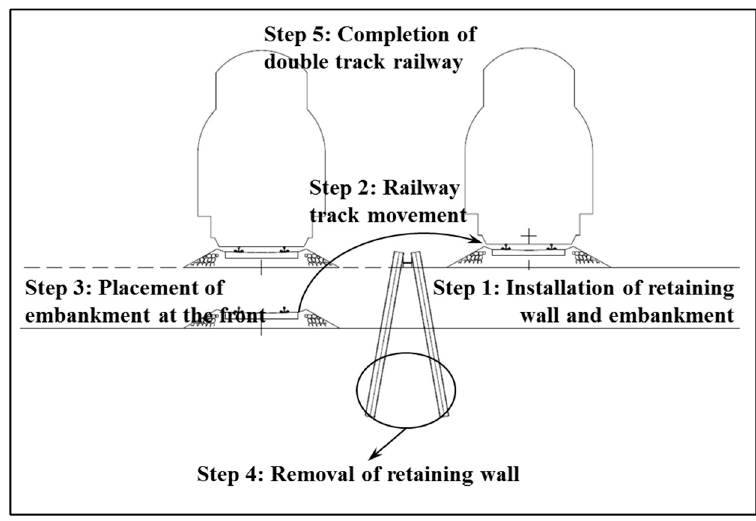
Figure 2. Construction method applied for double-track railway.